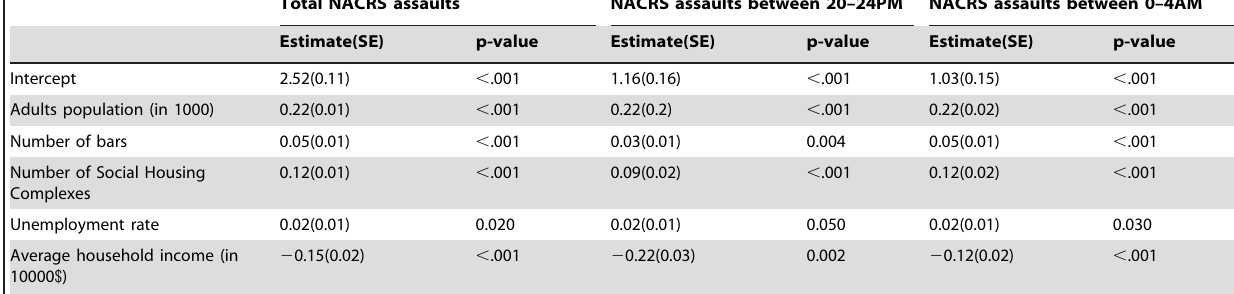
Table 3. Poisson Regression Estimates of Number of NACRS